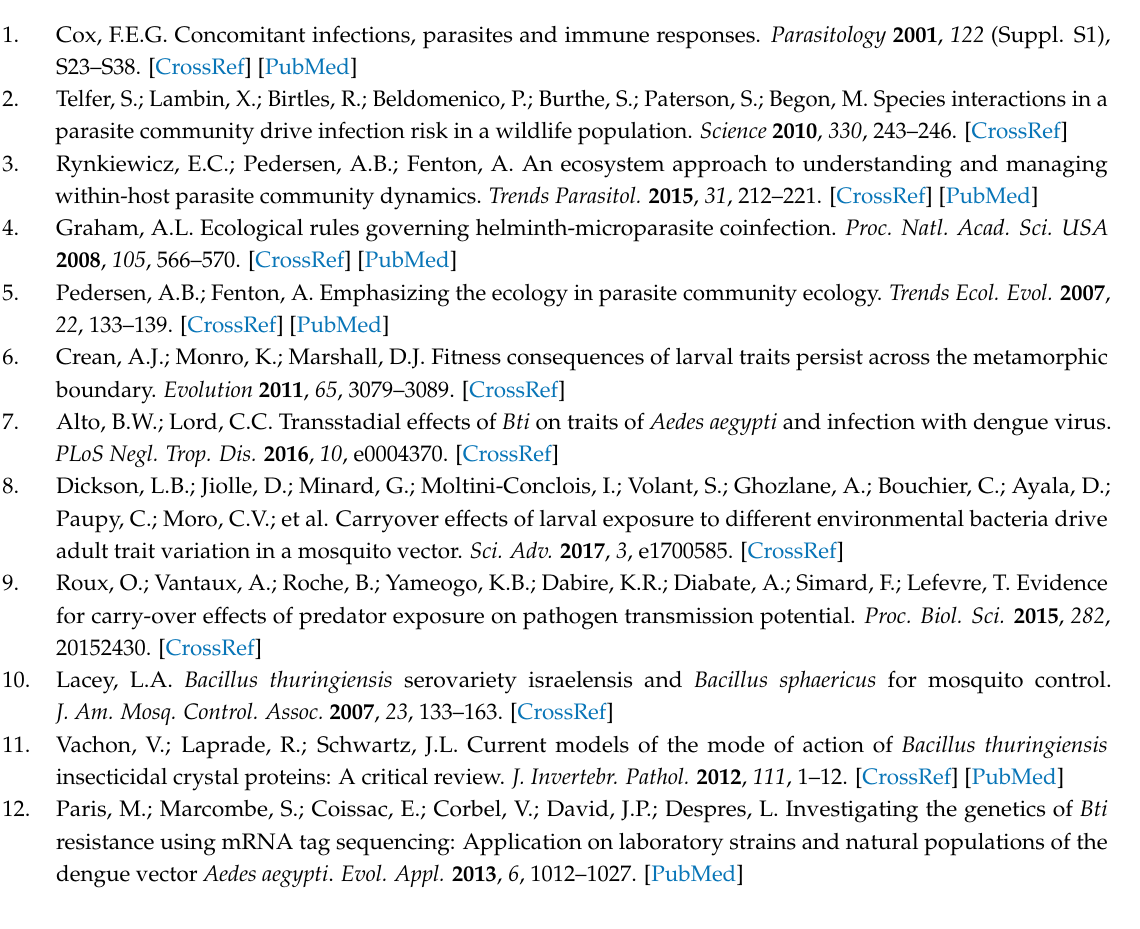
Table S1. Raw dataset. For each strain, treatment and arbovirus, the susceptibility phenotypes are indicated (0 = uninfected; 1 =